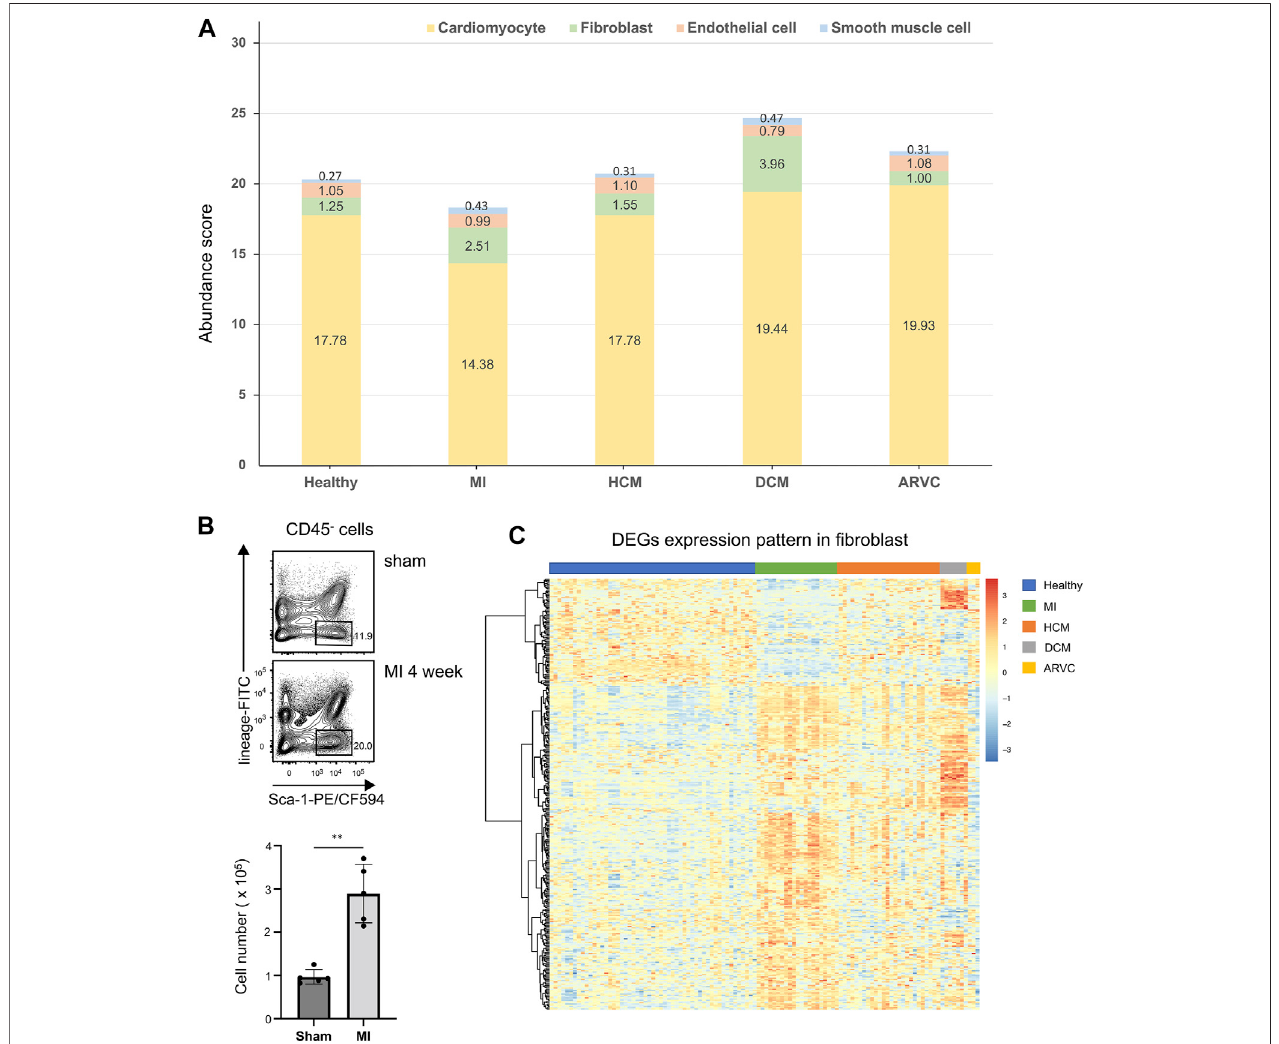
FIGURE3| Cellabundanceanalysisoffourmajorcelltypesofreconstructedhearttranscriptomesacrossvariouscardiacdiseaseconditions. (A) Barplotsshowing thevariationintheproportionsofthefour majorcelltypesacrossdifferentcardiac diseases.Each colorrepresentsaspeci fi ccelltype. (B) Flowcytometryassayverifying that fi broblastsareincreasedinmousehearttissuesofmyocardialinfarctionatthef4thweekaftermodelpreparation.Thetoppanelshowsarepresentativesampleofthe fl ow cytometry, and the lower panel is the statistical chart ( n = 5, p = 1.185 × 10 – 3 , Student ’ s t -test). Gating strategy: CD45.2- lineage (TER119 + CD31)- Sca-1+. (C) Heat map showing the overall differentially expressed gene expression pattern of fi broblasts across different disease conditions.